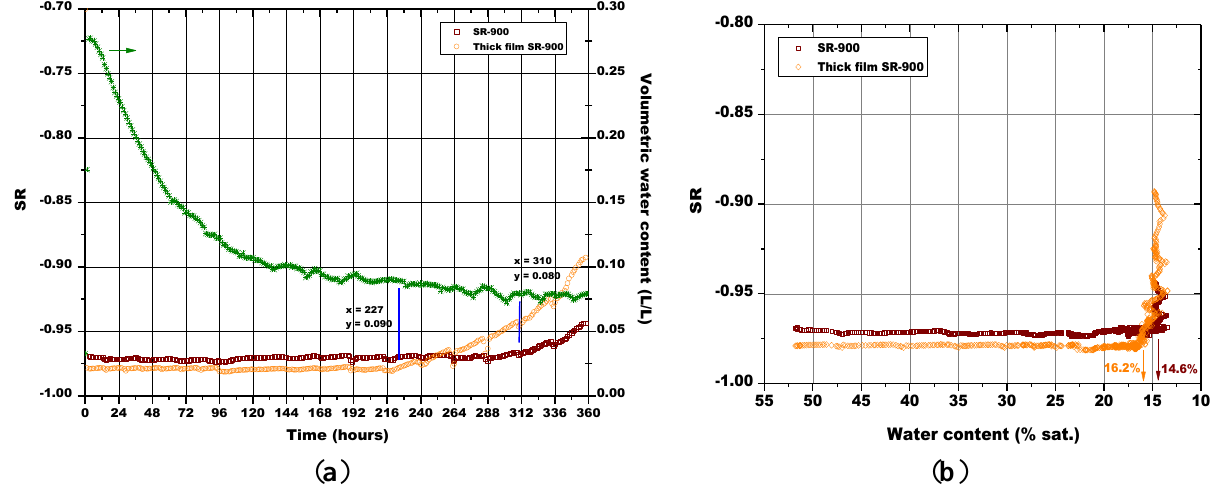
Figure 17. ( a ) Evolution of: the sensors response and of soil water content in function of time; ( b ) The sensors response in function of soil water content; comparison between a massive and a thick film sensor of Sr-doped hematite (soil temperature = 36.0 °C ± 1.0 °C, soil density about 1.28 g/cm 3